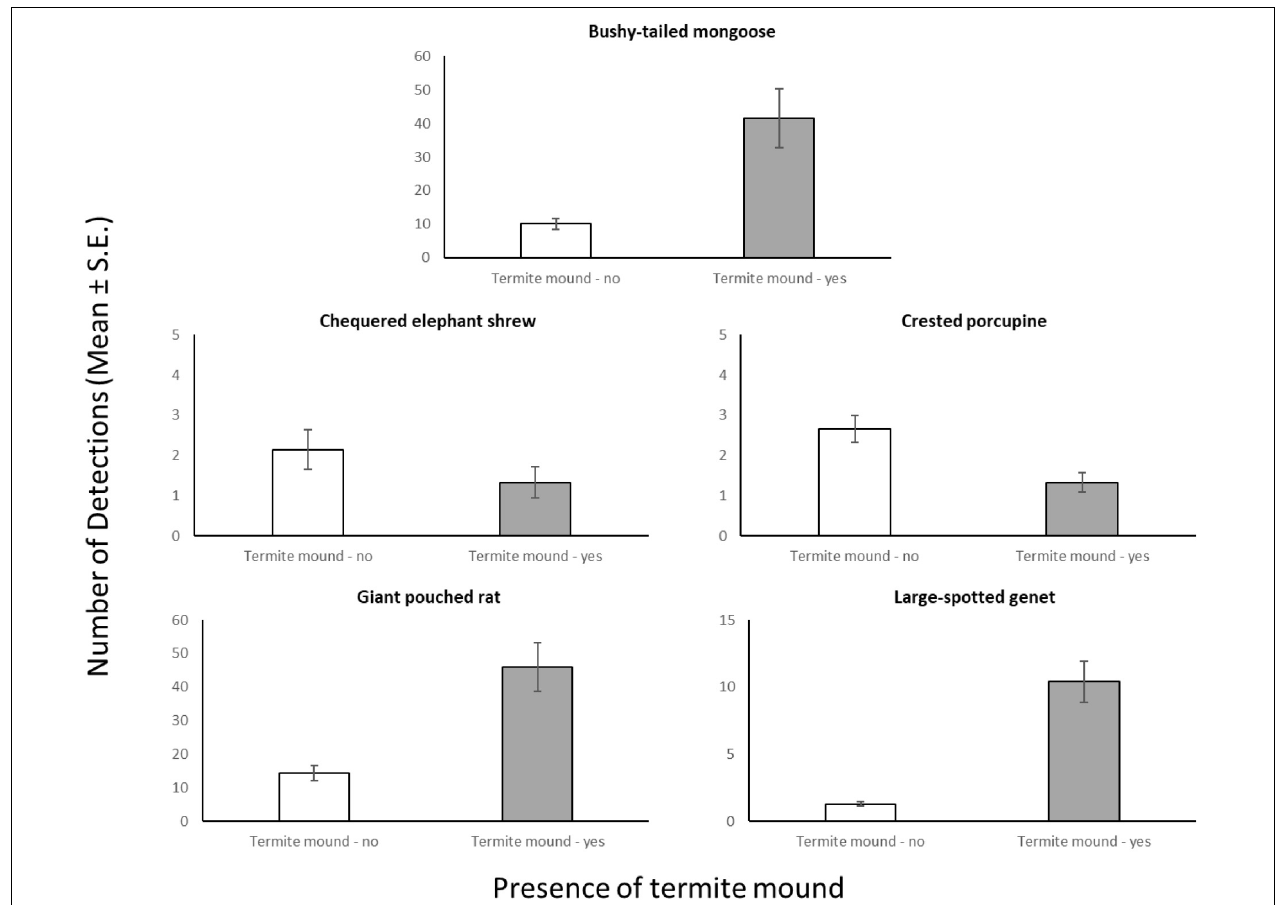
FIGURE 3 | Average number of camera days (Mean ± S.E.) in which each meso-mammal species was detected, compared between CT sites located at termite mounds ( n = 15) and sites with no termite mounds in close proximity ( n =